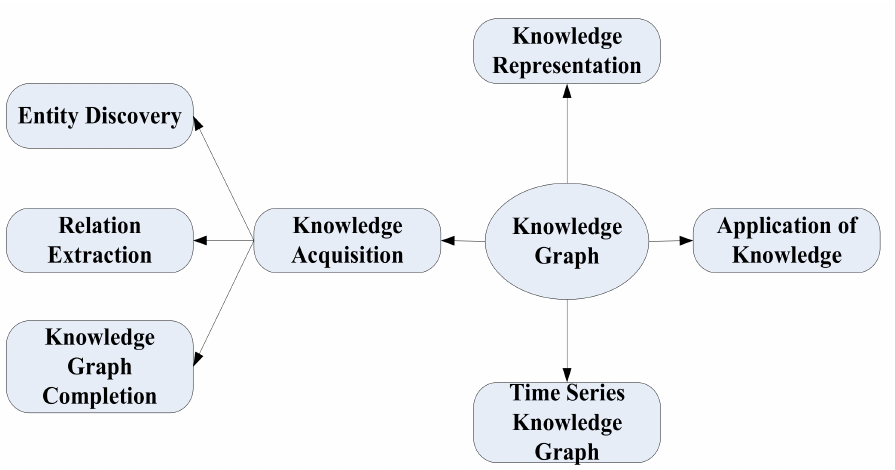
Figure 1. Main research directions of knowledge